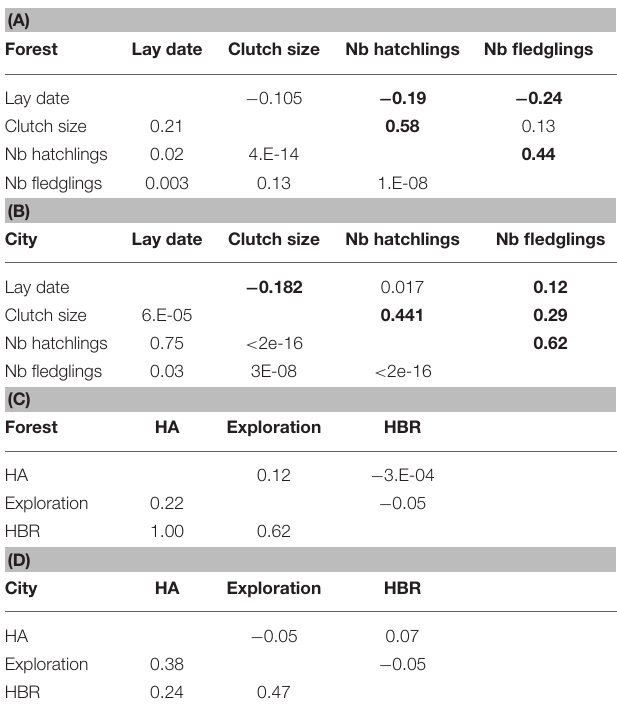
TABLE 1 | Phenotypic correlations (above the diagonal) among (A,B) breeding traits (in forest and city) and (C,D) behavior and physiological traits (in forest and city), and their associated P -values (below the